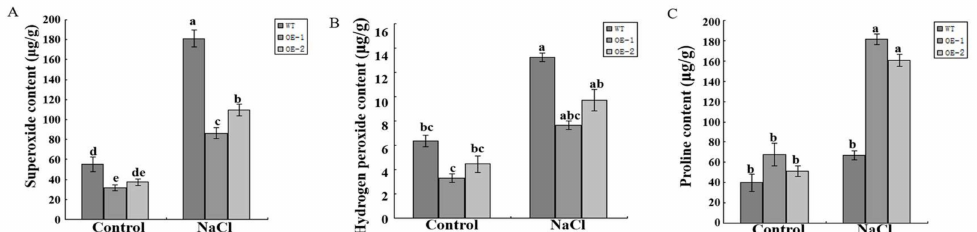
Figure 9. ( A – C ) were respectively the contents of superoxide, hydrogen peroxide, and proline in WT, OE-1, and OE-2 tomato plants, respectively. The same letter in the same growing season means no significant di ff erences among three biological replicates ( p < 0.05). Error bars represent